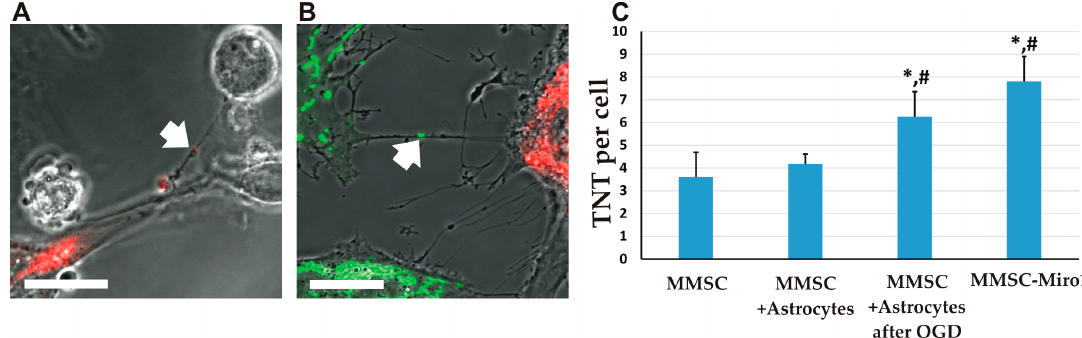
Figure 2. Mitochondria transfer from MMSCs to neural cells is supported by tunneling nanotubes (TNT). Formation of TNT between MMSC with DsRed-labelled mitochondria and unlabeled PC12 cells ( A ) and MMSC with GFP-labelled mitochondria and DsRed-labelled astrocytes ( B ); MMSC-derived mitochondria are seen in TNT (arrows). More TNTs are observed after OGD or overexpression of Miro1 in MMSC ( C ). Scale bars = 20 µm ( A , B ). All experiments were performed at least in triplicate; *,# denotes significant differences with respect to the MMSC group ( p < 0.05) or the MMSC + Astrocytes group, (One-way ANOVA, followed by Tukey’s post hoc). Values are given as mean ± standard error of the mean (SEM).